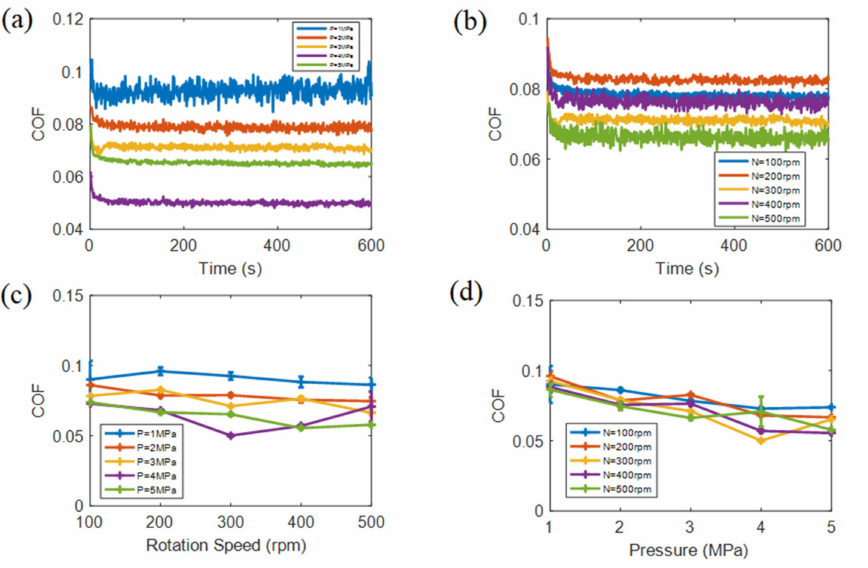
Figure 3. The COF under dry sliding, ( a ) COF vs. time with different loads under the middle speed of 300 rpm, ( b ) COF vs. time with different speeds under middle load of 3MPa, ( c ) average COF vs. speed and ( d ) average COF vs.